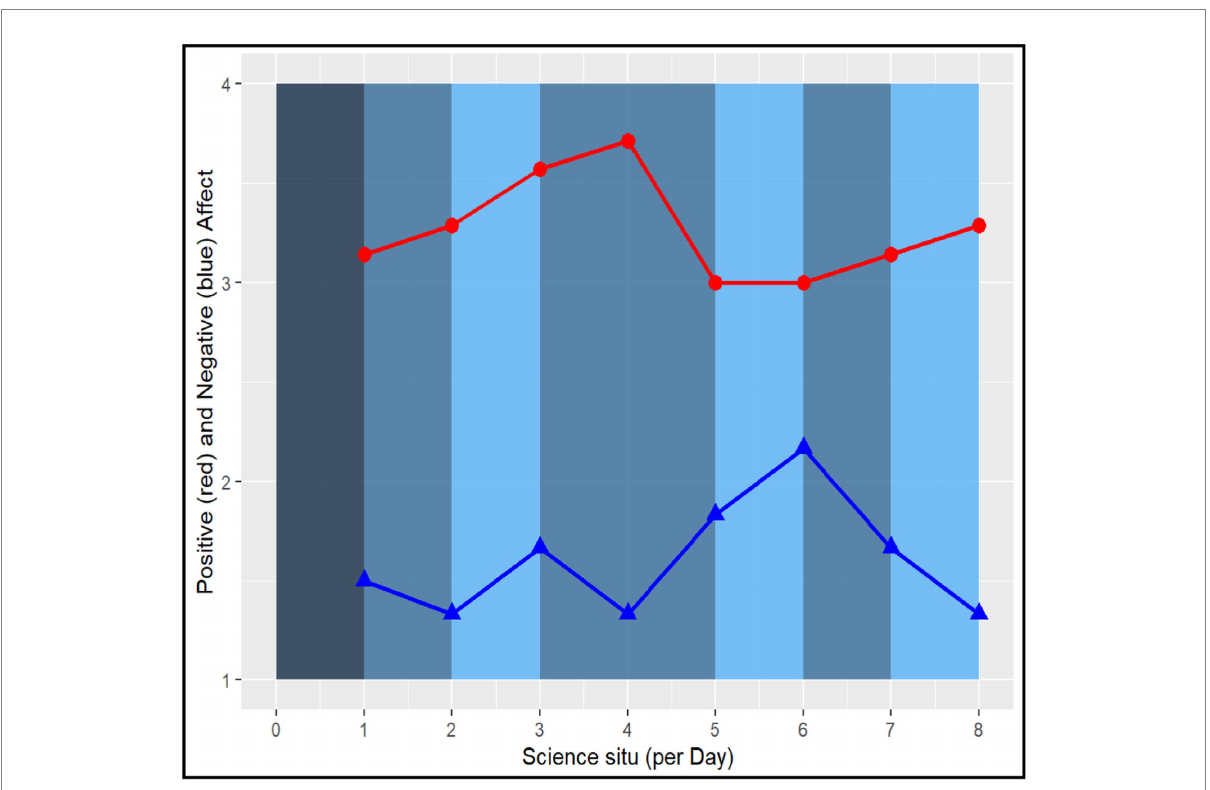
FIGURE 5 Dennis (Low-performing student) Experienced Challenge in Relation to Positive and Negative Psychological States. Report raw scores in positive and negative emotions. The dark blue color marks the lowest challenge moments (=1), whereas the light blue color marks the highest challenge moments (=4) in the science